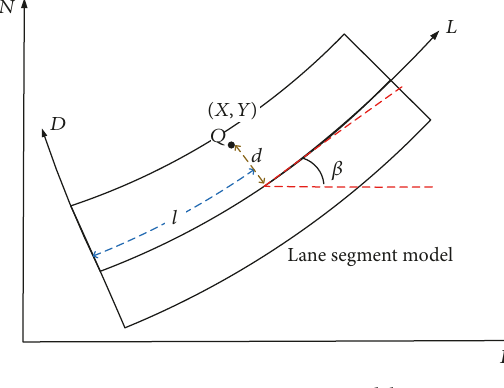
Figure 2: Lane segment